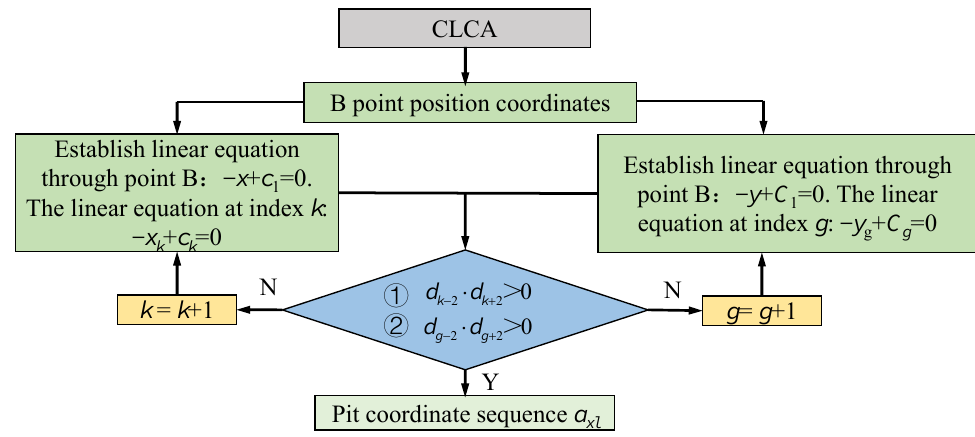
Figure 8. Principle of closed ‐ loop crossover algorithm (CLCA).